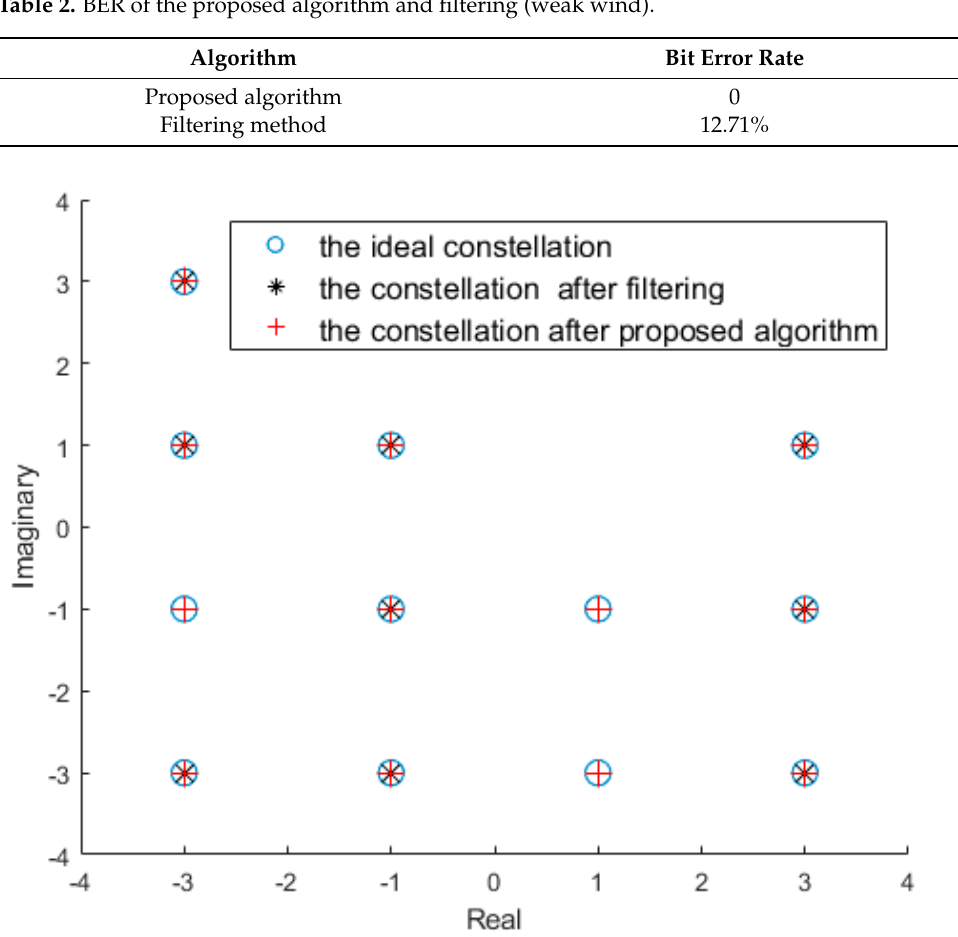
Table 2. BER of the proposed algorithm and fi ltering (weak wind).